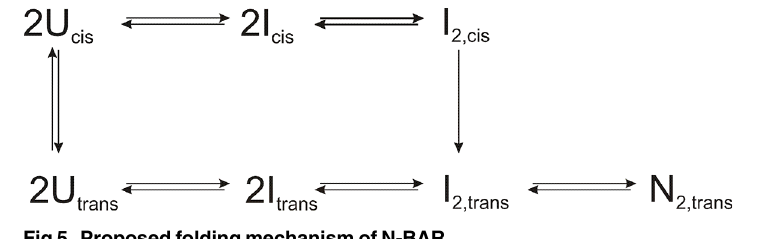
Fig 5. Proposed folding mechanism of